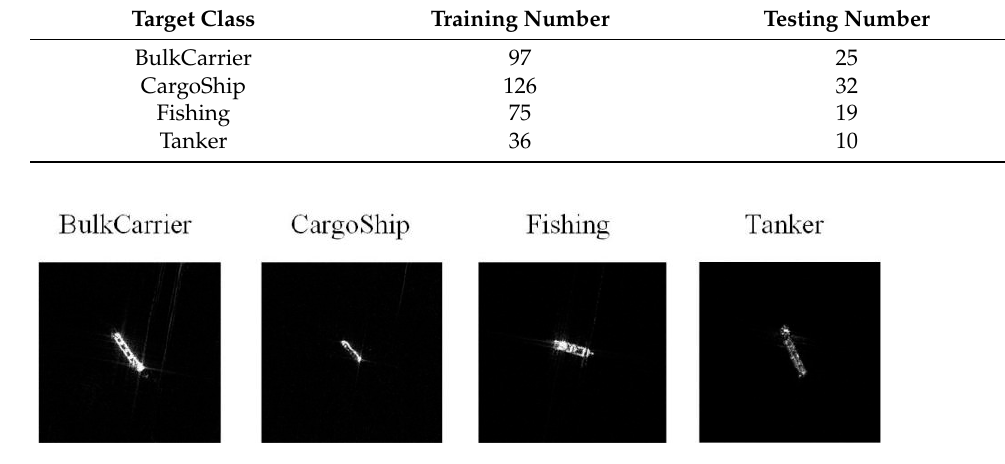
Figure 6. Example images from the FUSAR-Ship dataset.